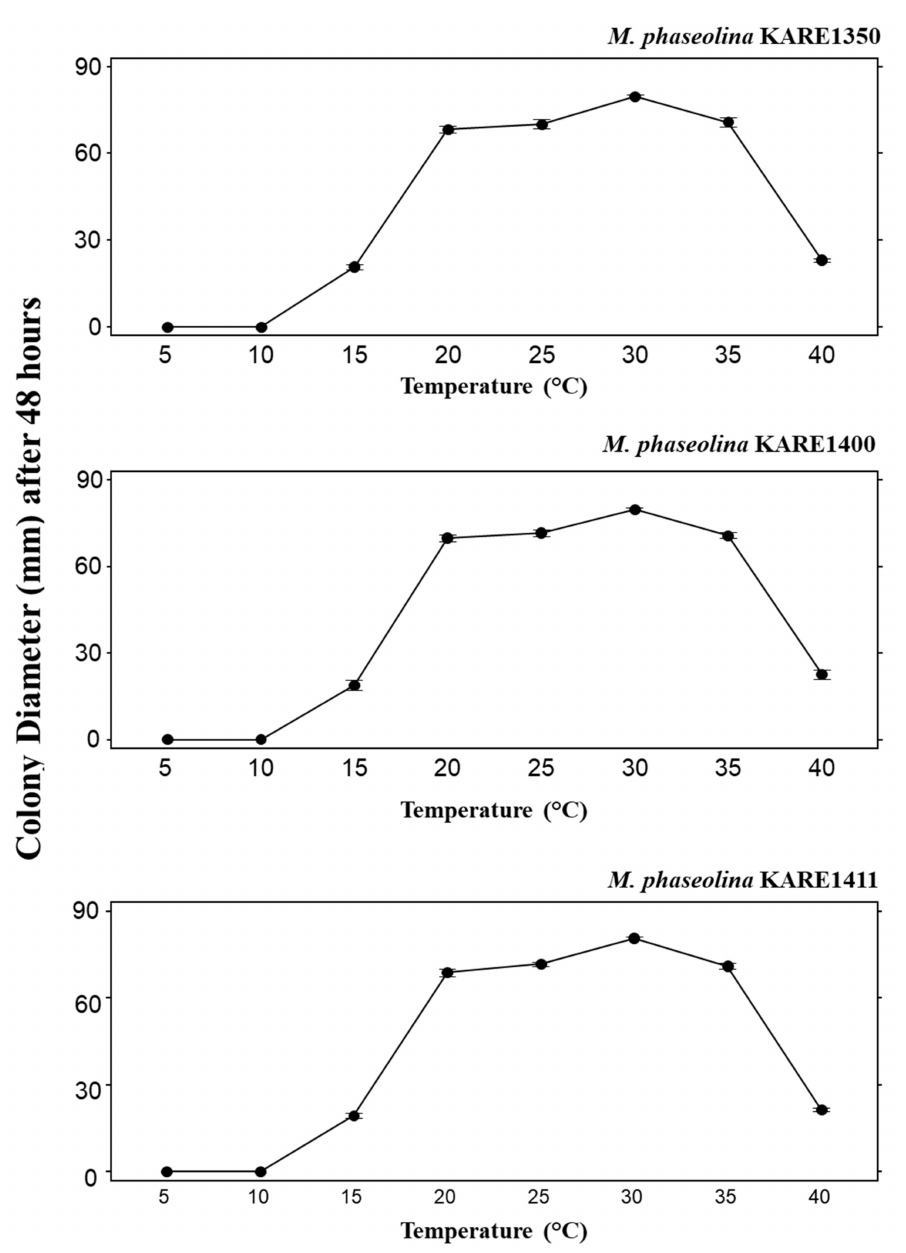
Figure 4. E ff ect of the temperature on the mycelial growth of three isolates of Macrophomina phaseolina : KARE1350, KARE1400 and KARE1411 on potato dextrose agar after 48 h of incubation. Error bars represent the standard error of the